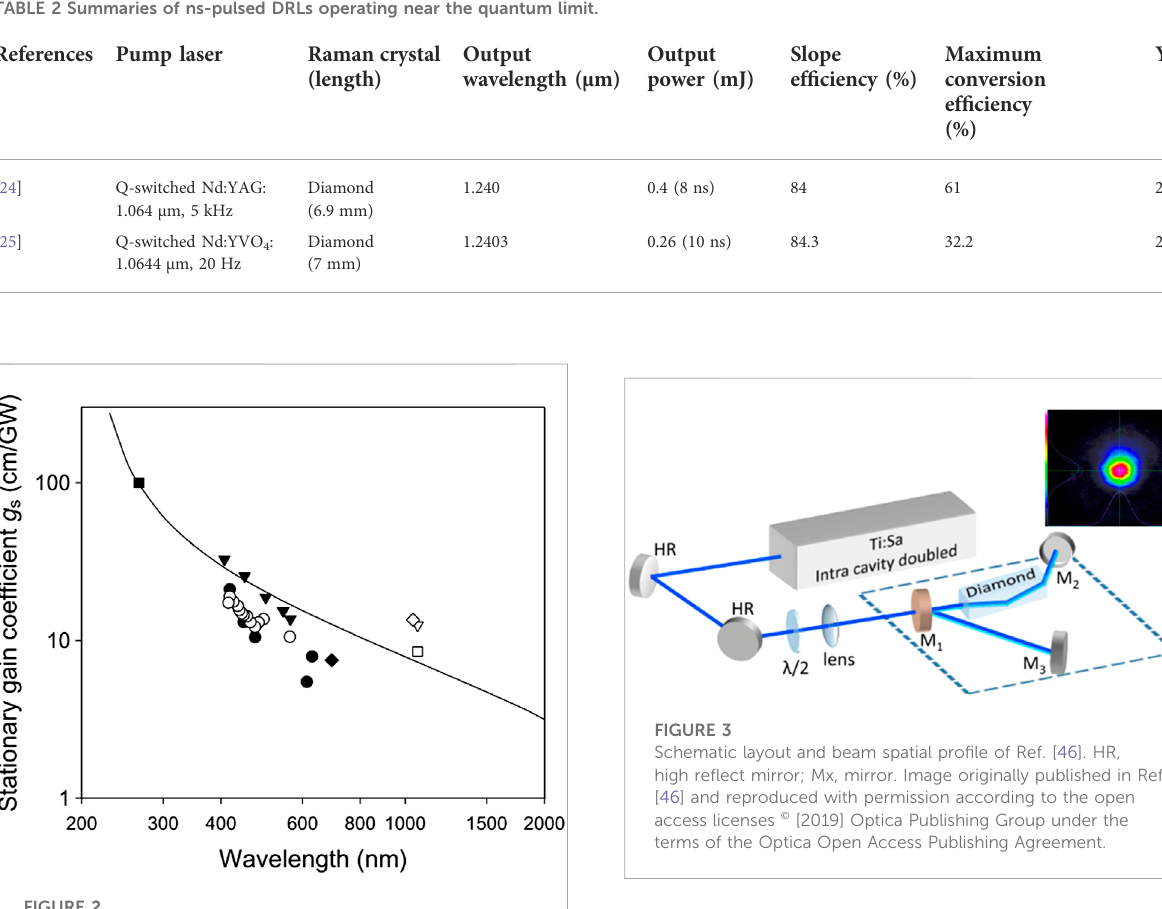
FIGURE 2 Stationary gain coef fi cient as a function of pump wavelength. Reference to the data points are summarized in Ref. [44]. The curve using Equations (1.13), (1.14) and (1.20) in Ref. [44].